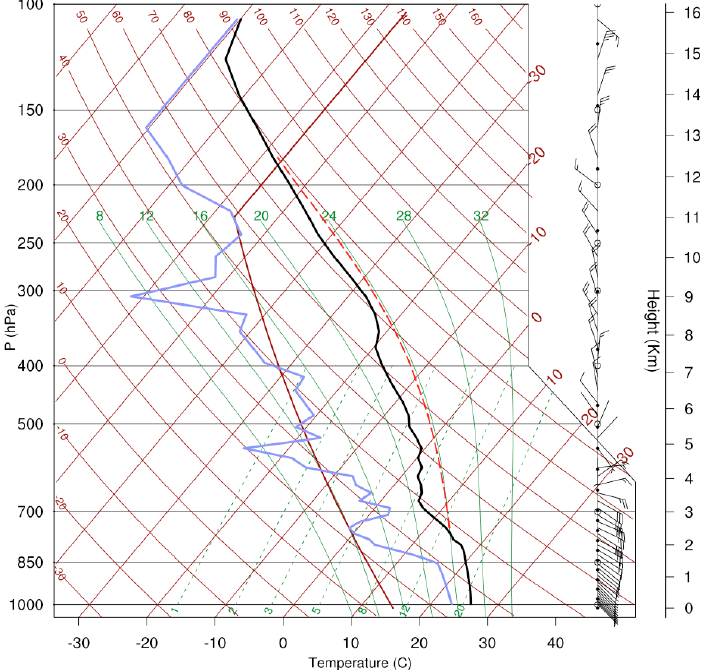
Fig. 3. Sounding used in the horizontally-homogeneous simulation initialization. Temperature and dew point are plotted as black and blue lines, respectively. Wind speed is reported in knots, where a full barb is equivalent to 10 knots.